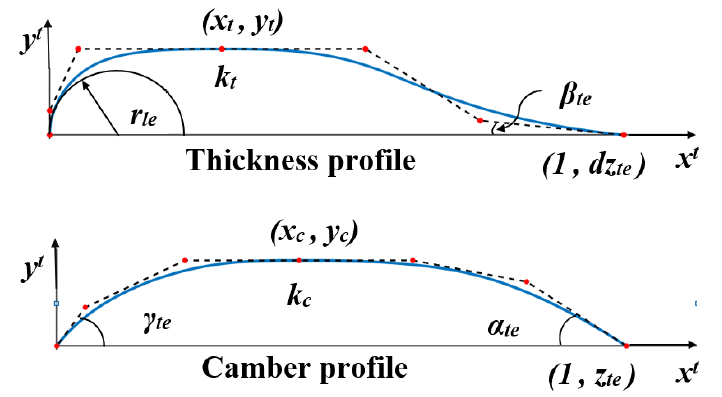
Figure 3. BP 3333 airfoil geometry and Bezier control points defined by twelve basic aerodynamic parameters.